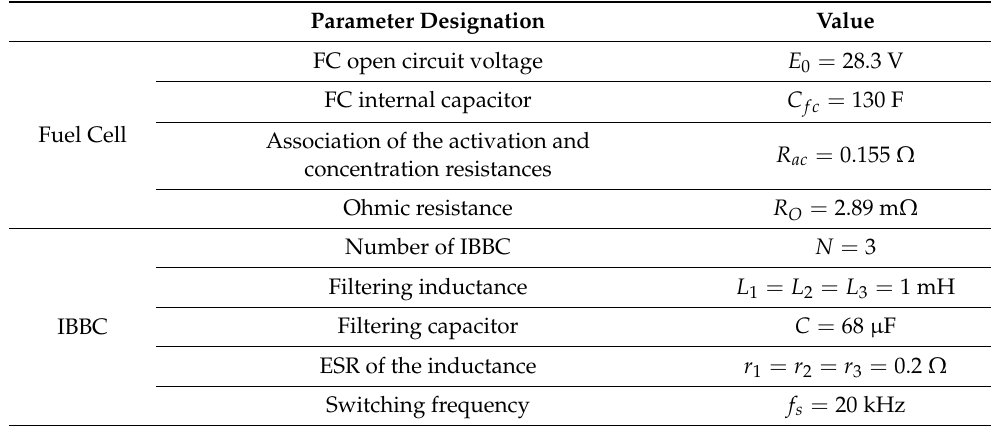
Table 2. Controlled system